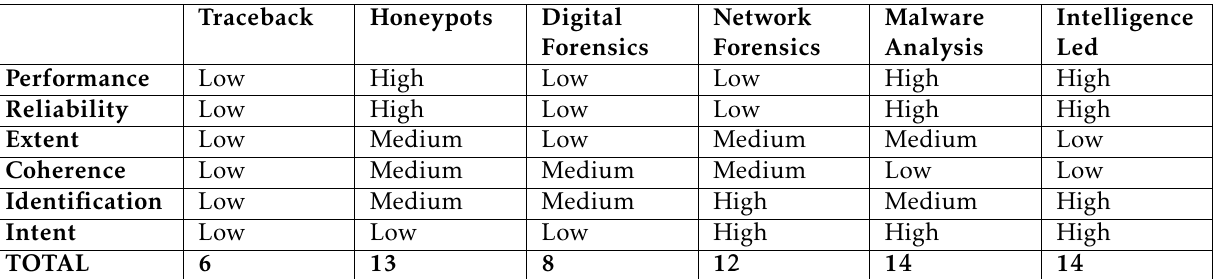
Table 2. Summary of Attribution Technique